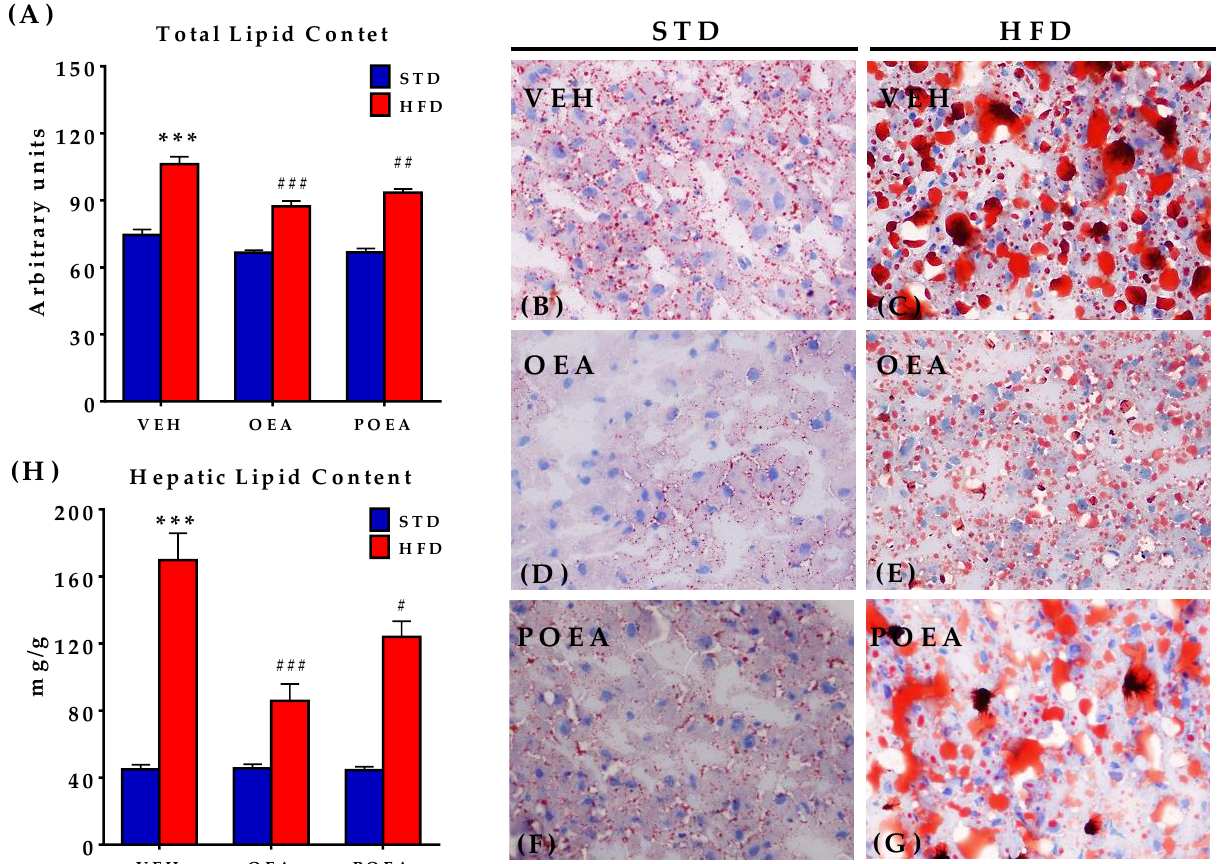
Figure 10. Effect of sub-chronic (15 days) administration of a 10 mg/kg dose of either oleoylethanolamide (OEA) or palmitoleylethanolamide (POEA) in liver in hypercaloric cafeteria diet (HFD) male Sprague–Dawley rats on hepatic lipid content ( A ) in standard diet (STD) and HFD, and corresponding representative images of liver fat content with oil red O staining, taken under a microscope with 40 × objective ( B–G ). ( H ) Measurement of the total fat content in liver. Bars are means ± standard error of the mean SEM per group ( n = 6 samples per group) analyzed by two-way ANOVA (diet and treatment, with Bonferroni post-hoc test). (***) p < 0.001 significant differences compared with STD vehicle (VEH) group; (#) p < 0.05, (##) p < 0.01, and (###) p < 0.001 significant differences compared with HFD VEH group.